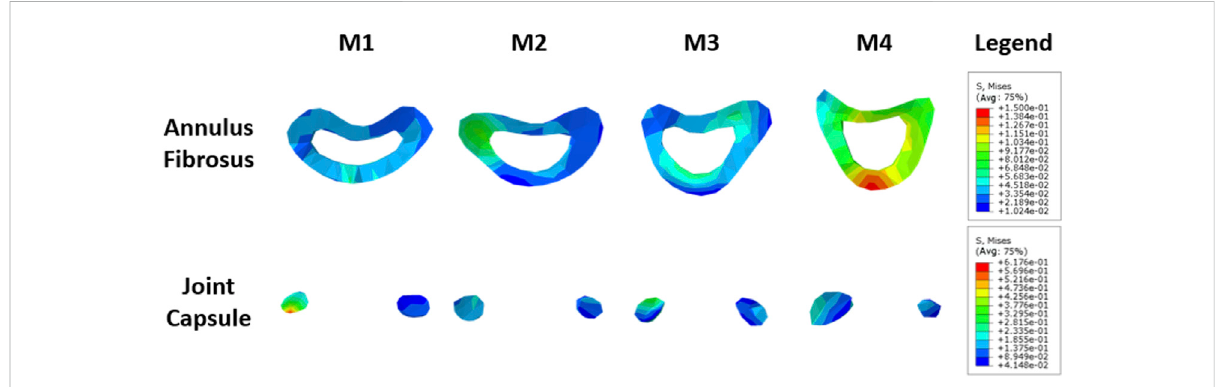
FIGURE 12 Stress nephogram of annulus fi brosus and joint capsule.